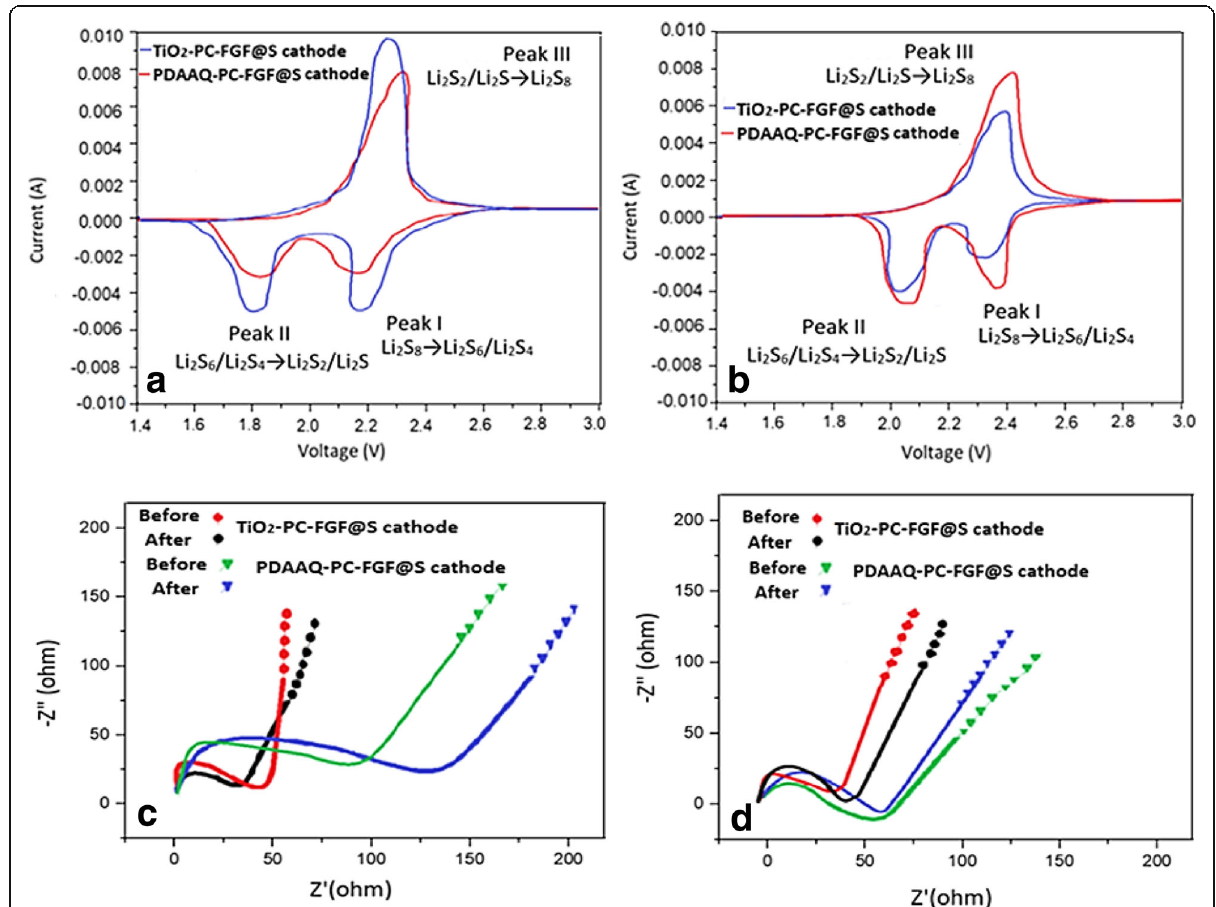
Fig. 6 CV curves of Li-S cells at scan rate of 0.2 mV S − 1 a with PDAAQ/PC-FGF separator, b with PDAAQ/PC-FGF/CTAB separator, c electrochemical impedance spectrum (EIS) curves of PDAAQ/PC-FGF separator with two different cathodes 1st and 100th cycles at 0.5 C, d EIS curves of PDAAQ/ PC-FGF/CTAB separator with two different cathodes 1st and 100th cycles at 0.5